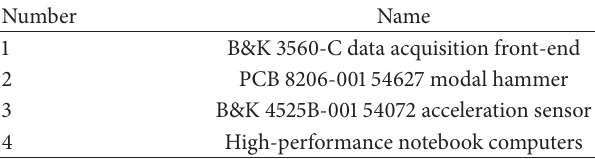
Table 1: The instruments used in this